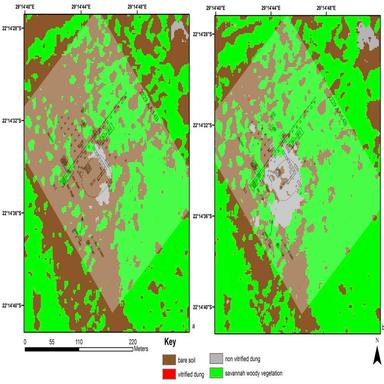
Plan of site AA 14B drawn by overlaid on both random (a) forest and SVM (b) classified images.